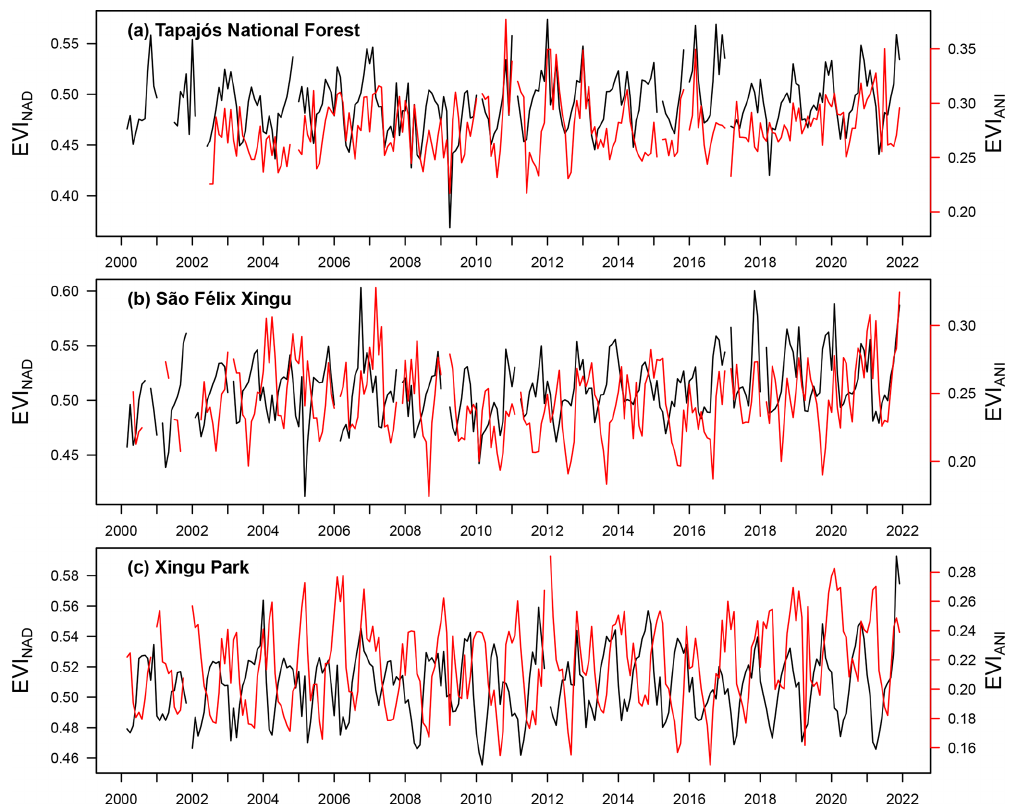
Figure 4. Time series of AnisoVeg’s MODIS enhanced vegetation index (EVI) from 2000 to 2021 for old-growth forests of (a) Tapajós National Forest, (b) São Félix do Xingu, and (c) Xingu Indigenous Park. The black line indicates the nadir-normalized signal (NAD layer), while the red line represents the EVI anisotropy (ANI layer). The profiles are the mean value of 3 × 3 pixels, whose locations are indicated by triangles in Fig. 3.